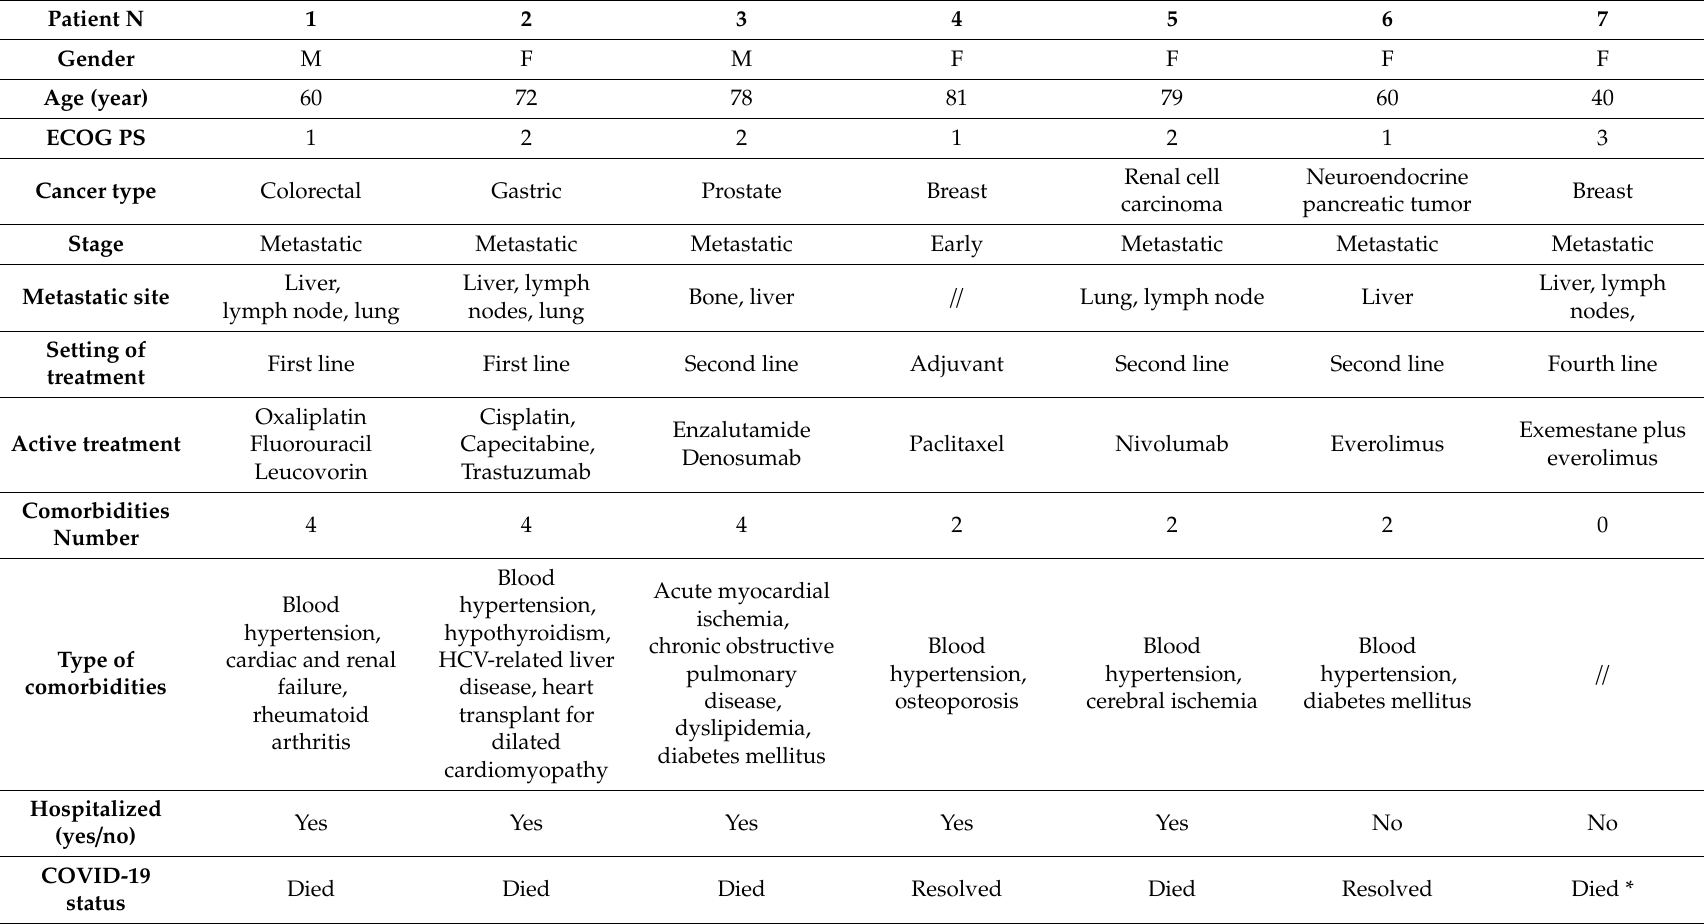
Table 2. Characteristics of patients with